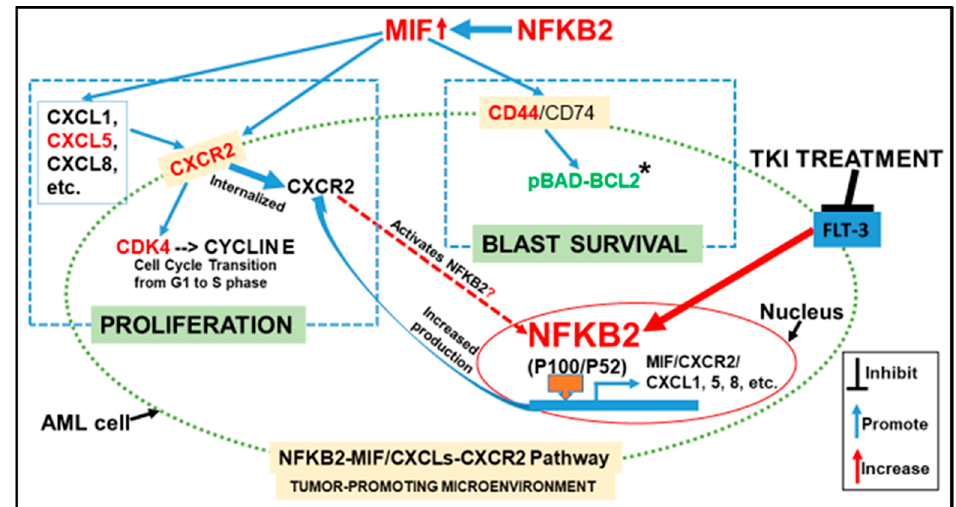
Figure 7. Schematic diagram depicting TKI-activated NFKB2-MIF/CXCLs-CXCR2 compensation pathways responsible for the survival and proliferation of AML blasts. After TKI treatment, cytotoxicity-induced injury signals might directly activate the non-canonical NFKB2 (P100/P52) pathway to release more MIF, CXCL5, CXCL8 and other tumor-promoting cytokines. MIF might act as an autocrine signal to initiate the survival mechanism* through MIF-CD74/CD44 pathways. Meanwhile, MIF-CXCR2, CXCL5-CXCR2 and CXCL8-CXCR2 pathways might be responsible for cell proliferation by activating CDK4/CYCLIN E-based transition from G1 to S phase of the cell cycle progression. * pBAD-BCL2: Phosphorylation of BAD has been restored by PIM family compensation pathways to prevent its binding to BCL-2, allowing blasts to survive the TKI treatment. Red color indicates the key molecules in this study.